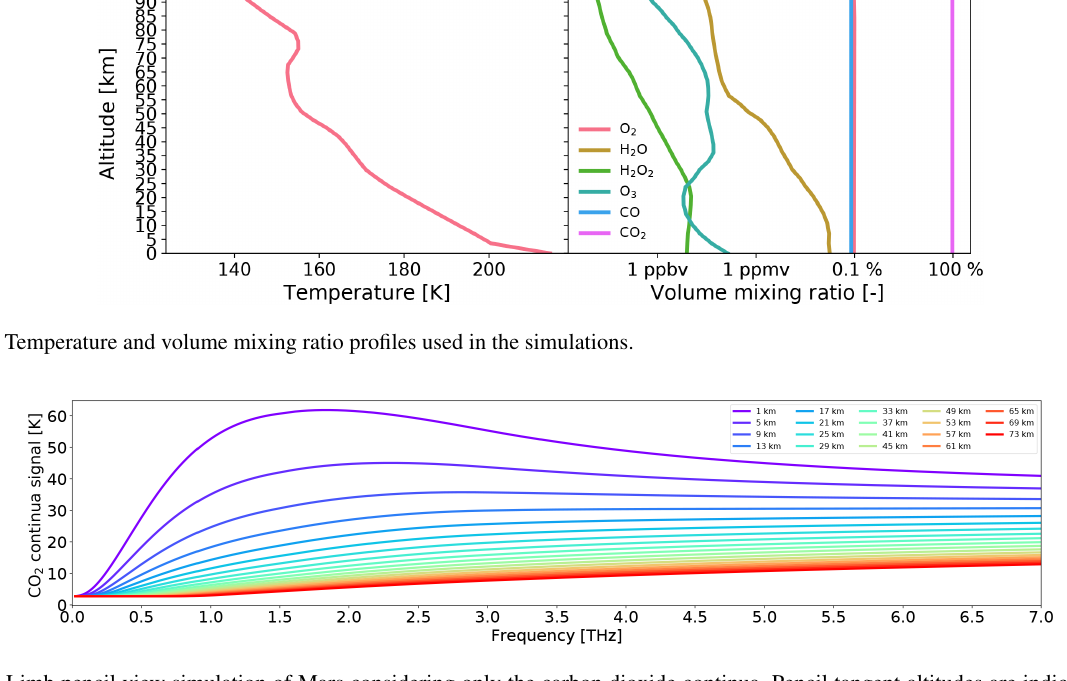
Figure 3. Limb pencil view simulation of Mars considering only the carbon dioxide continua. Pencil tangent altitudes are indicated by the legend. The increase in the signal at higher altitudes and higher frequency is probably a consequence of the extrapolation of the model